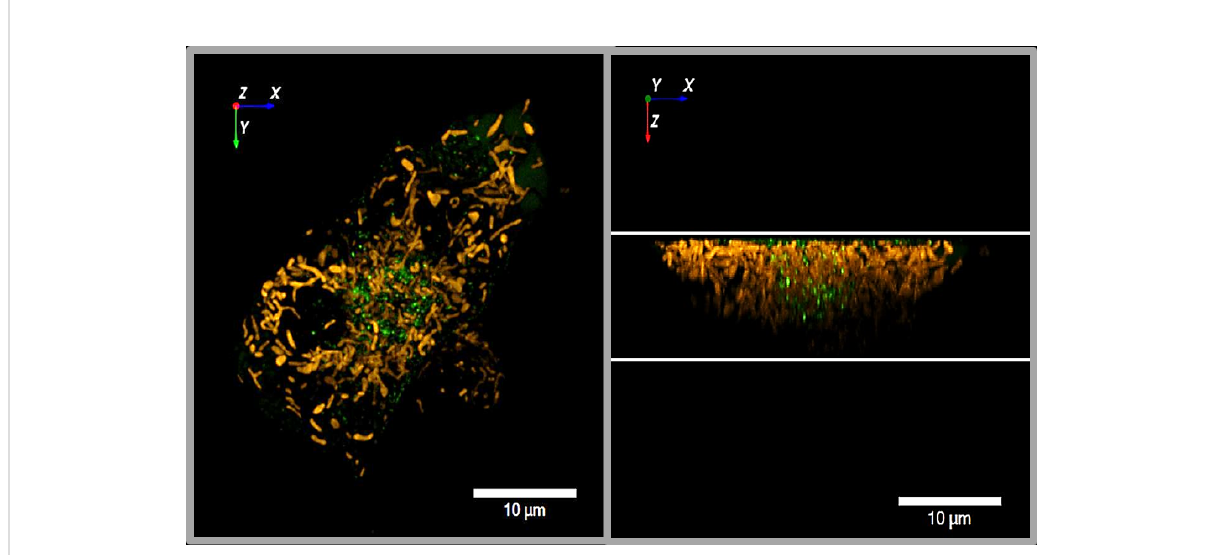
FIGURE 5 Presence of insulin granules and mitochondria in the submembrane space of MIN6 cells. The insulin granules of MIN6 cells were transiently labelled with hIns-EGFP (green) and mitochondria by loading with TMRE. The image acquisition of the z-stack was performed as in Figure 3. The left image shows the cell from the bottom - attachment to the cover slip, the right image shows the lateral view to demonstrate the high concentration of mitochondria in the immediate vicinity of the submembrane